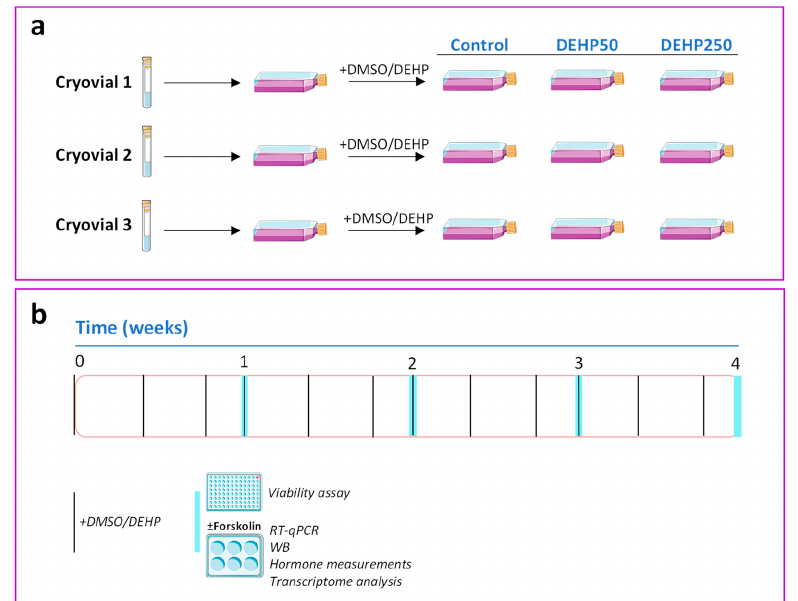
Figure 1. Experimental design of the long-term exposure of HGrC1 cells to DEHP. ( a ) Three different cryopreserved stock vials of HGrC1 cells were thawed into three 25 cm 2 cell culture flasks and cultured for two weeks, after which the cells from each flask were divided into three 75 cm 2 flasks. During the next four weeks, HGrC1 cells were subcultured twice a week and exposed to either vehicle (0.05% DMSO-control) or DEHP (50 nM or 250 nM in 0.05% DMSO) three times a week. ( b ) Different endpoint measurements were taken after 1, 2, 3, and 4 weeks of exposure. Pictures were obtained from Servier Medical Art (https://smart.servier.com/).